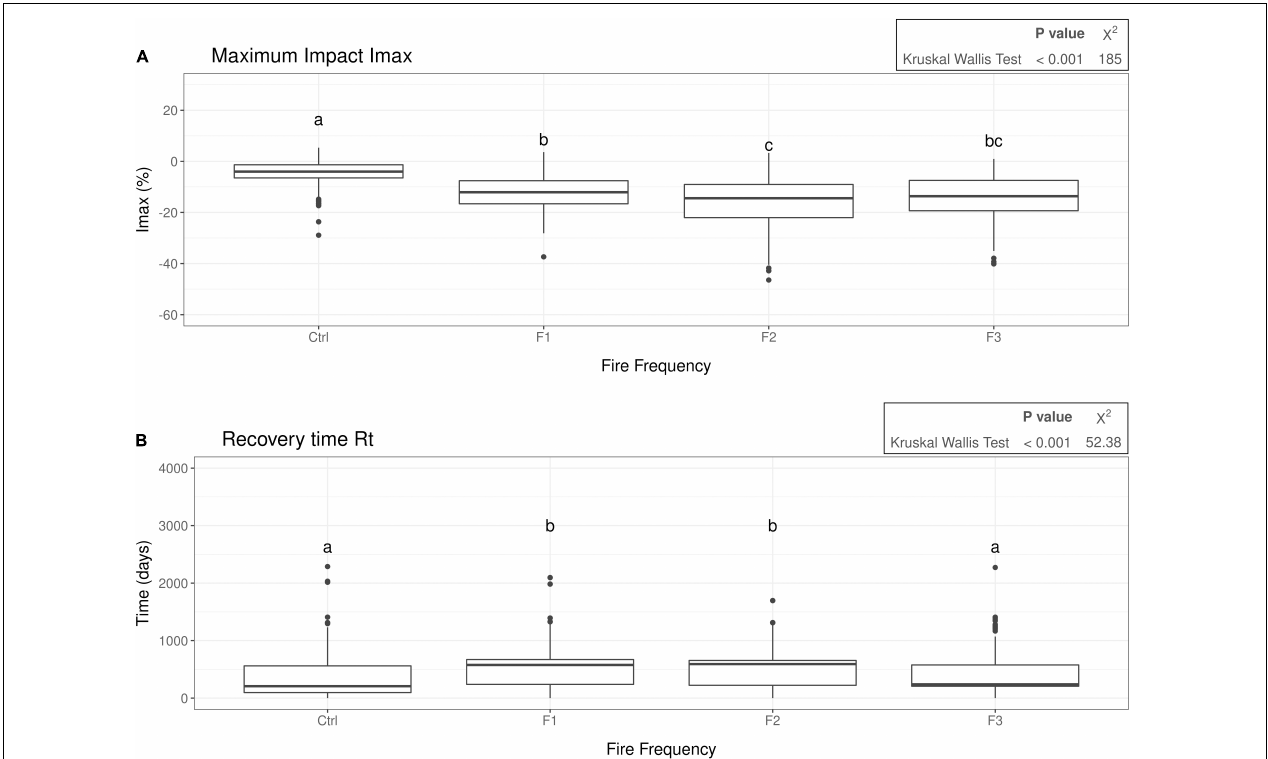
FIGURE 3 | Box plots showing the maximum fire impact (I max ) (A) and the recovery time to the baseline (Rt), i.e., the number of days after fire (or Aug 24 2010 for Control data points) until the baseline is reached again (B) and how they differ between the fire frequencies (Ctrl = control, no fire; F1 = 1 fire event, F2 = 2 fire events, F3 = 3 fire events). Both Rt and I max were calculated for the fire in the year 2010 and are measures of the recovery and resistance, respectively. The letters at the top of each box plot represent the significance groups obtained after a multiple comparison test. The output of the Kruskal-Wallis test ( p -value and Chi squared statistic) is shown at the top right of each box